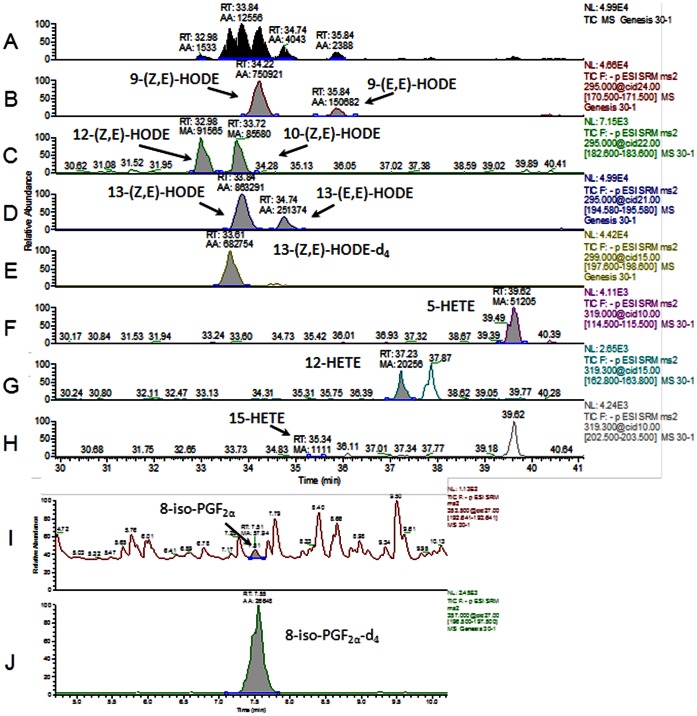
Typical chromatograms obtained from LC-MS/MS of human plasma samples measured in this study.(a) Total ion chromatogram, (b) 9-(Z,E)- and (E,E)-HODE, (c) 10- and 12-(Z,E)-HODE, (d) 13-(Z,E)- and (E,E)-HODE, (e) 13-(Z,E)-HODE-d4, (f) 5-HETE, (g) 12-HETE, (h) 15-HETE, (i) 8–iso-PGF2α, and (j) 8-iso-PGF2α-d4.